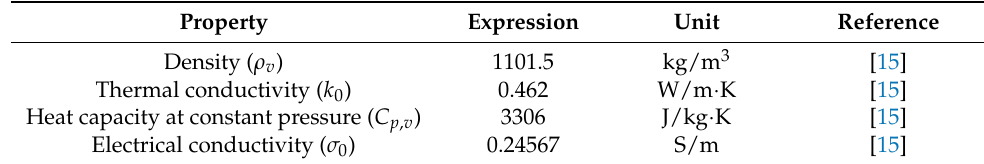
Table 1. The basic properties of the